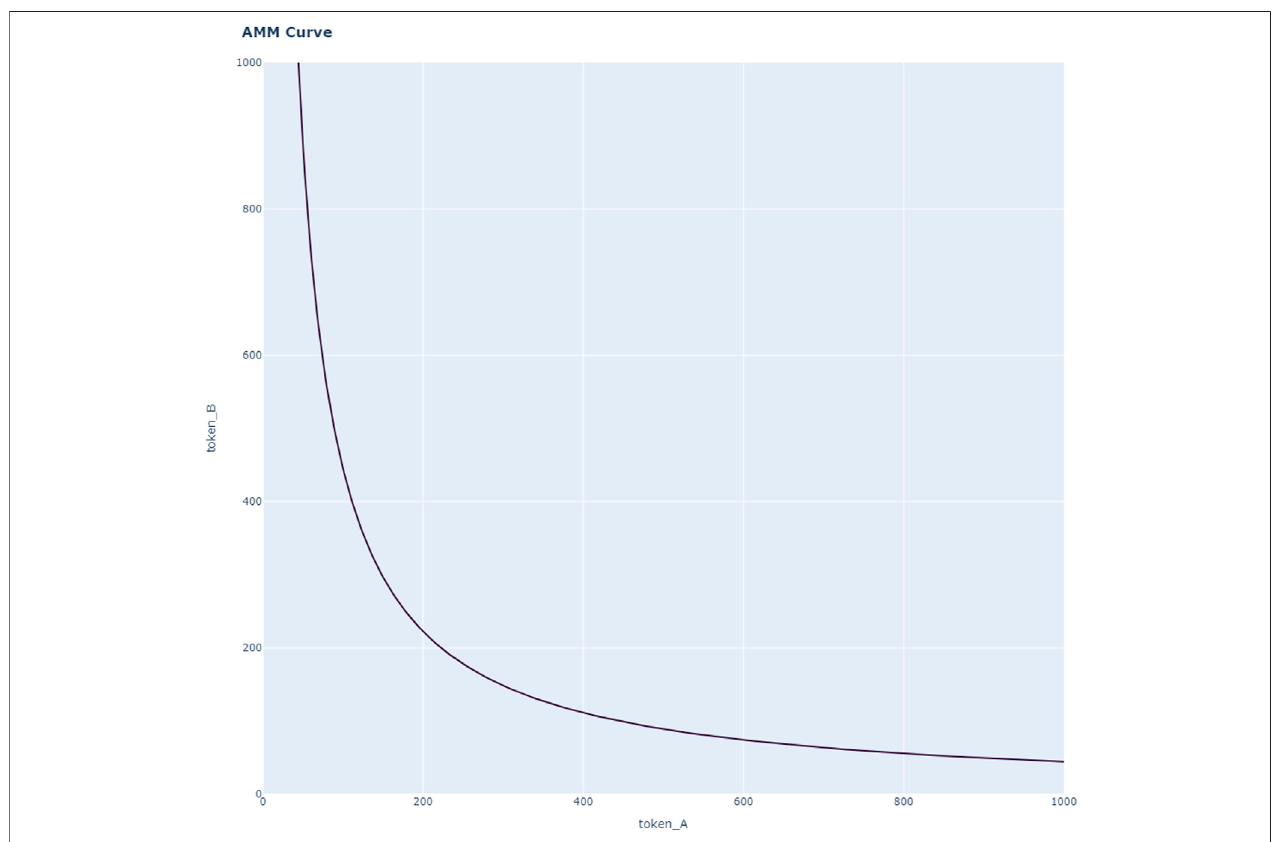
FIGURE 1 | The Uniswap constant product pricing function ( x * y = k